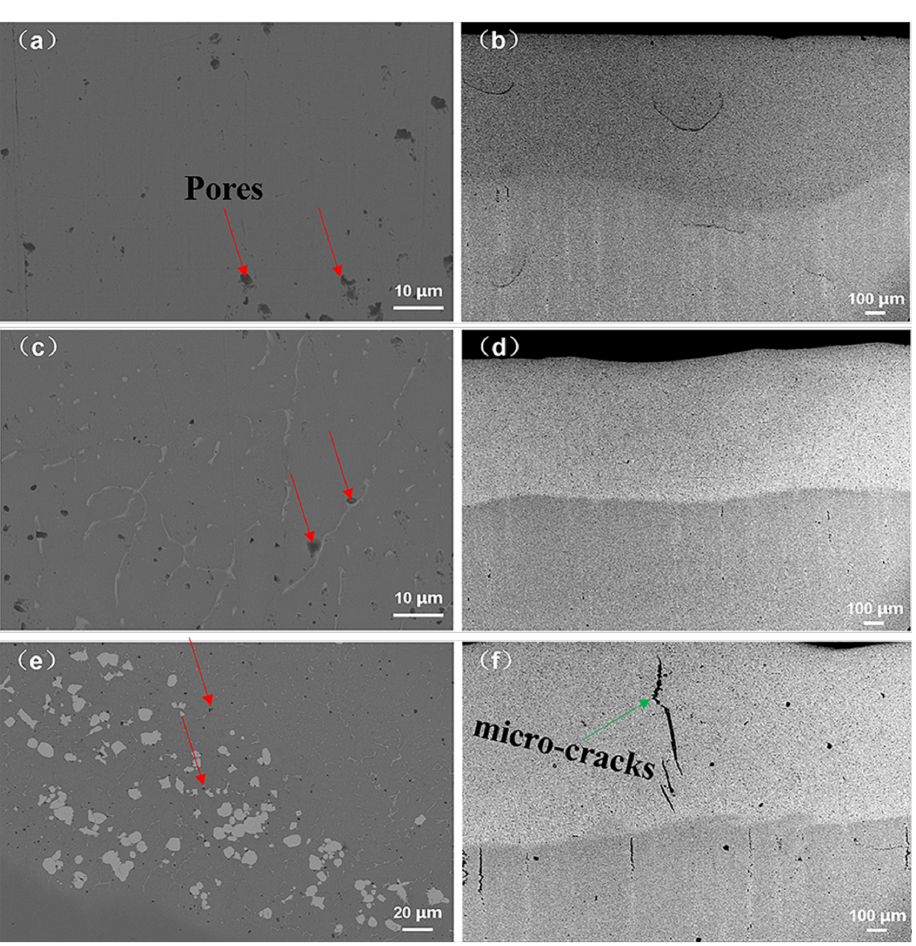
Figure 3. Surface and cross-sectional FESEEM images of the AlCoCrFeNiW x HEA coatings: ( a , b ) x = 0, ( c , d ) x = 0.5, ( e , f ) x =